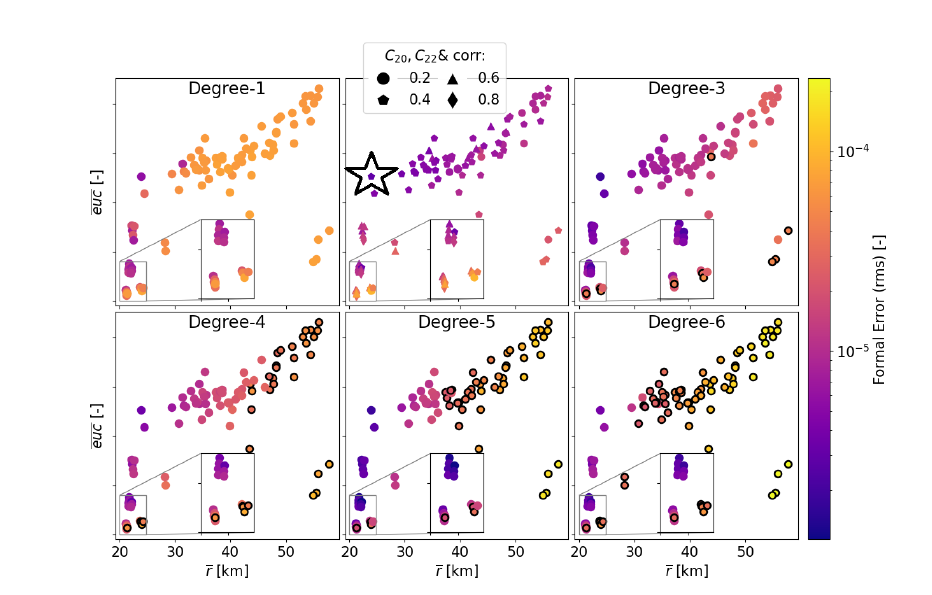
Figure 5. Gravity field recovery via RS at 24 h/day tracking capacity. Vertical and horizontal axes indicate coverage and proximity of the orbital solutions. The formal error root-mean-square is grouped per degree. Shapes reflect the correlation between C 20 and C 22 . Circled markers indicate that the formal errors cross the a priori standard deviations for all coefficients at that degree. The star denotes the best orbit in terms of accuracy across degrees 1 to 3, further expended in Figure 6.